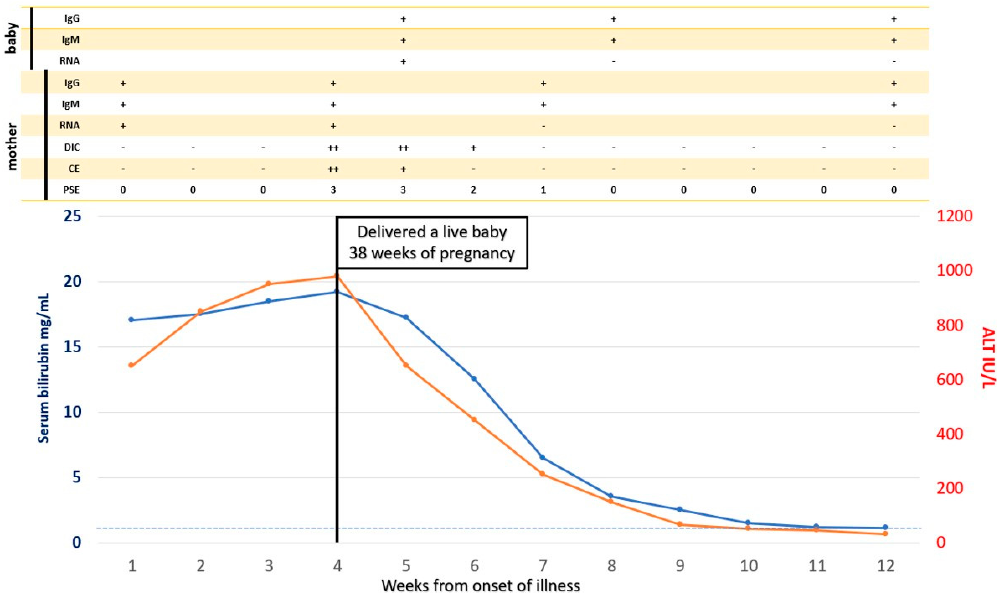
Figure 5. Spontaneous Vaginal Delivery in pregnancy with HEV-ALF and the outcome on maternal disease. A 30-year-old pregnant woman presented with features of icteric hepatitis E virus infection. On the 24th day of her illness, she had rapid deterioration with encephalopathy, cerebral edema, and laboratory features of DIC. She delivered a live baby vaginally with icteric hepatitis E four days after the onset of encephalopathy. Serial follow-up showed rapid clinical improvement in encephalopathy, cerebral edema, and DIC. PSE = portosystemic encephalopathy, CE = cerebral edema, DIC = disseminated intravascular coagulation, RNA = HEV RNA, IgM = IgM anti-HEV, IgG = IgG anti-HEV.